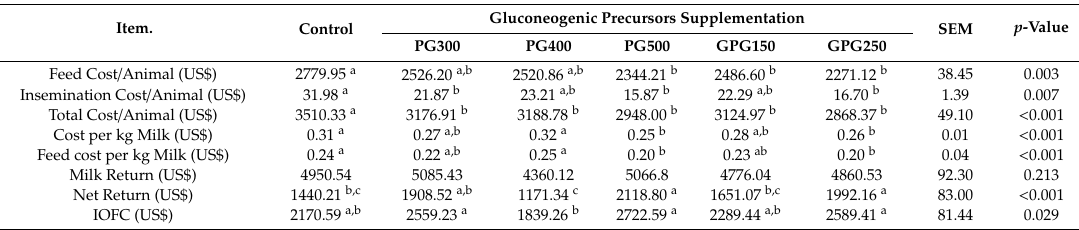
Table 6. E ff ect of di ff erent drenching regimens by gluconeogenic precursors on cost and return